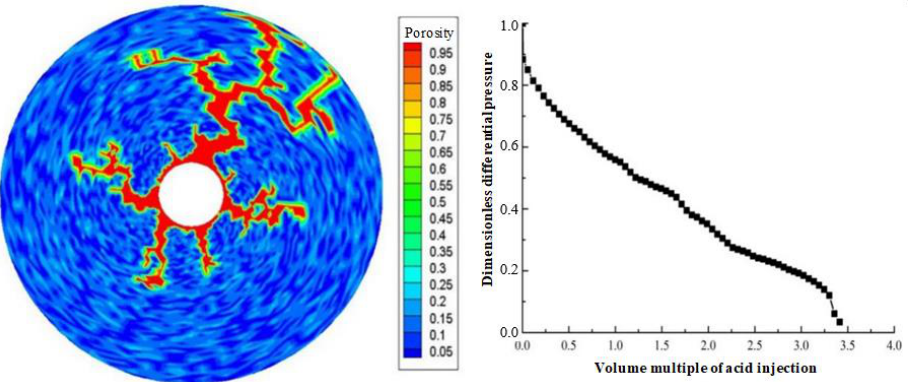
Figure 3. Change of dissolution form and differential pressure with gelling acid injection (gelling acid injection speed 0.035 cm/min).